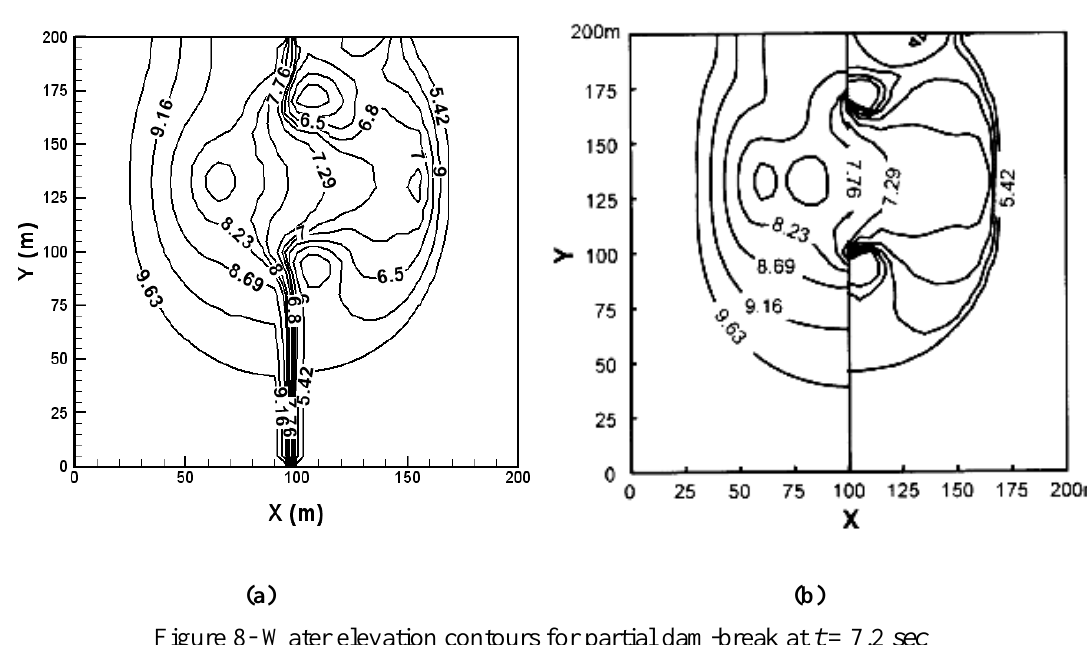
Figure 8- Water elevation contours for partial dam-break at t = 7.2 sec (a) obtained by the model and (b) reported in